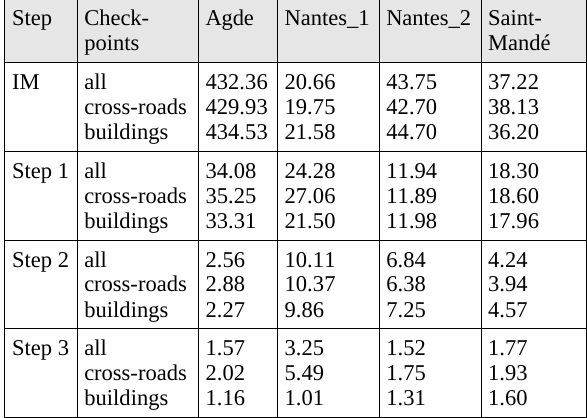
Table 3. Terrain residuals in meters at each step for the different kind of check-points (steps are the same as in Table 2)